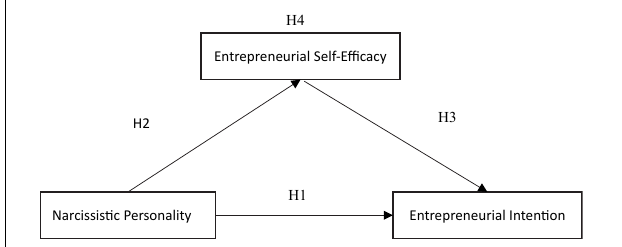
FIGURE 1 | Research